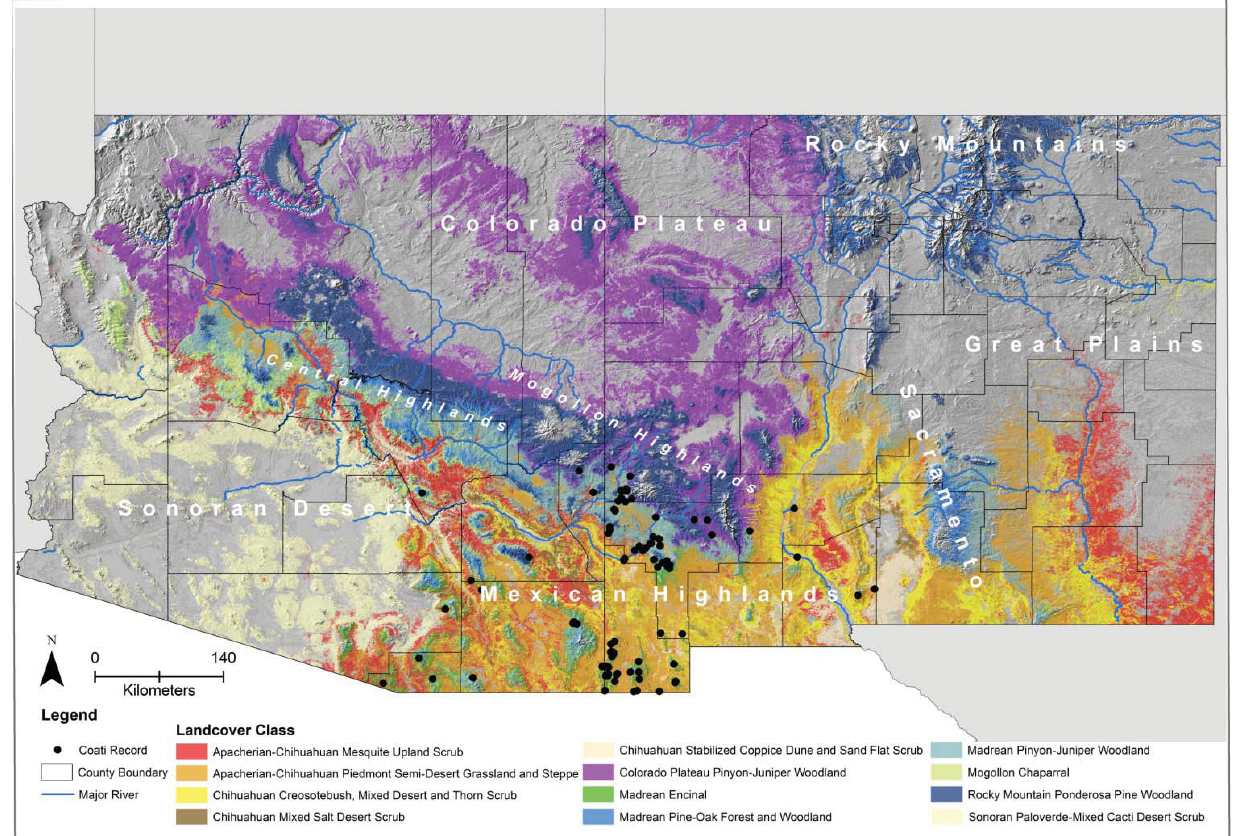
Figure 4. Map of land-cover types associated with the white-nosed coati ( Nasua narica ) in Arizona and New Mexico (see Table 5 for habitat suitability values for each land-cover). Dots represents observations of observations of coatis that included juveniles, pregnant females, or groups of three or more individuals, suggesting reproduction. Labels are physiographic